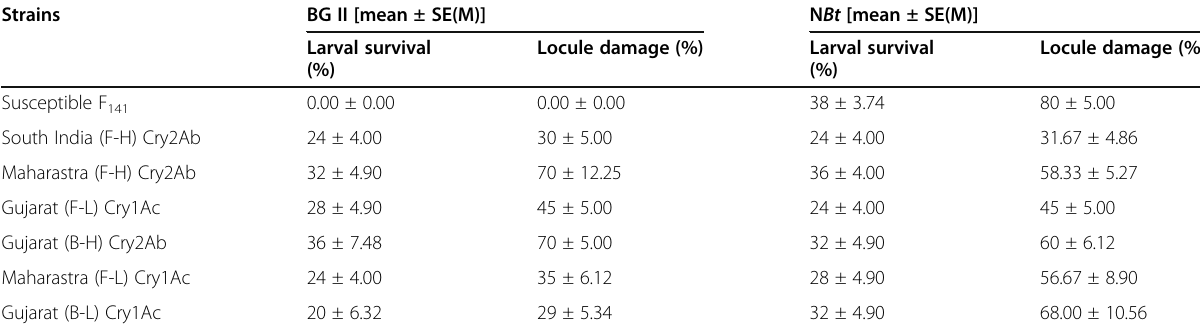
Table 3 Survival of resistant and susceptible neonates of Pectinophora gossypiella on cotton bolls Strains BG II [mean ±